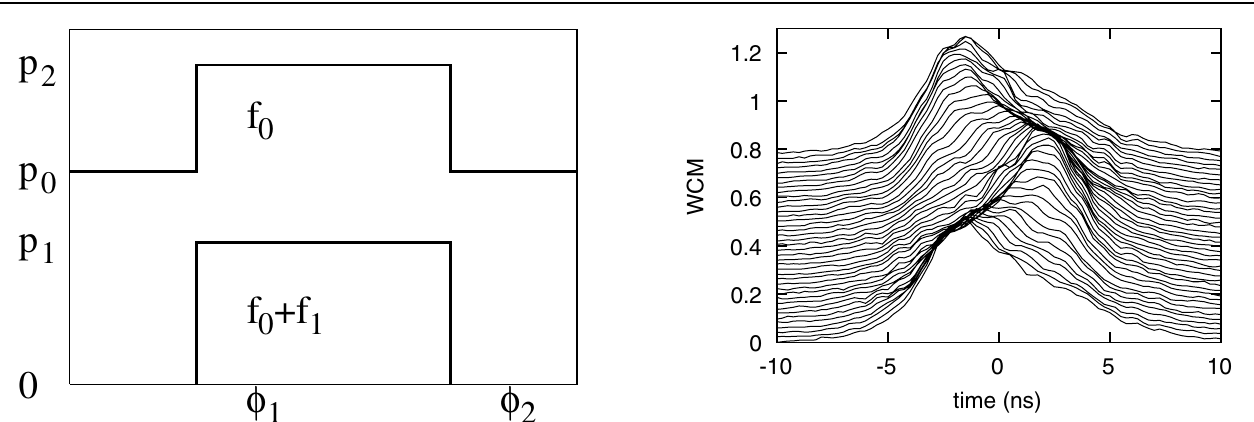
FIG. 1. Simple picture of a soliton in a coasting beam. The horizontal axis is (cid:3) , the longitudinal position within the bunch. The vertical axis is p (cid:1) d(cid:3)=dt . The density is symmetric in p and only the p > 0 portion is shown.